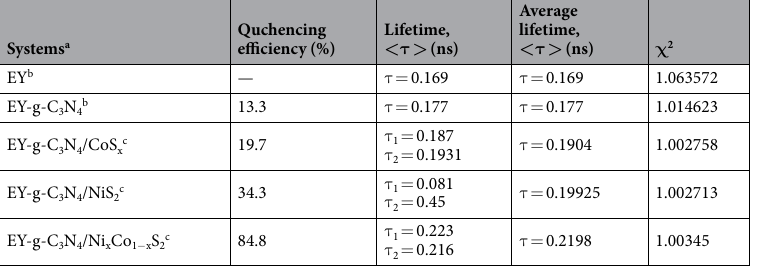
Table 1. Decay parameters of EY in the presence of g-C 3 N 4 /NiS 2 , g-C 3 N 4 /CoS x , and g-C 3 N 4 /Ni x Co 1 − x S 2 in 15% (v/v) TEOA aqueous solution at pH 10. a Decay of TEOA aqueous solution (15% v/v) of 1.0 × 10 − 6 mol L − 1 EY at pH 10 was recorded in the presence of 0.15 mg mL − 1 EY, EY-g-C 3 N 4 , EY-g-C 3 N 4 /NiS 2 , EY-g-C 3 N 4 /CoS x , and EY-g-C